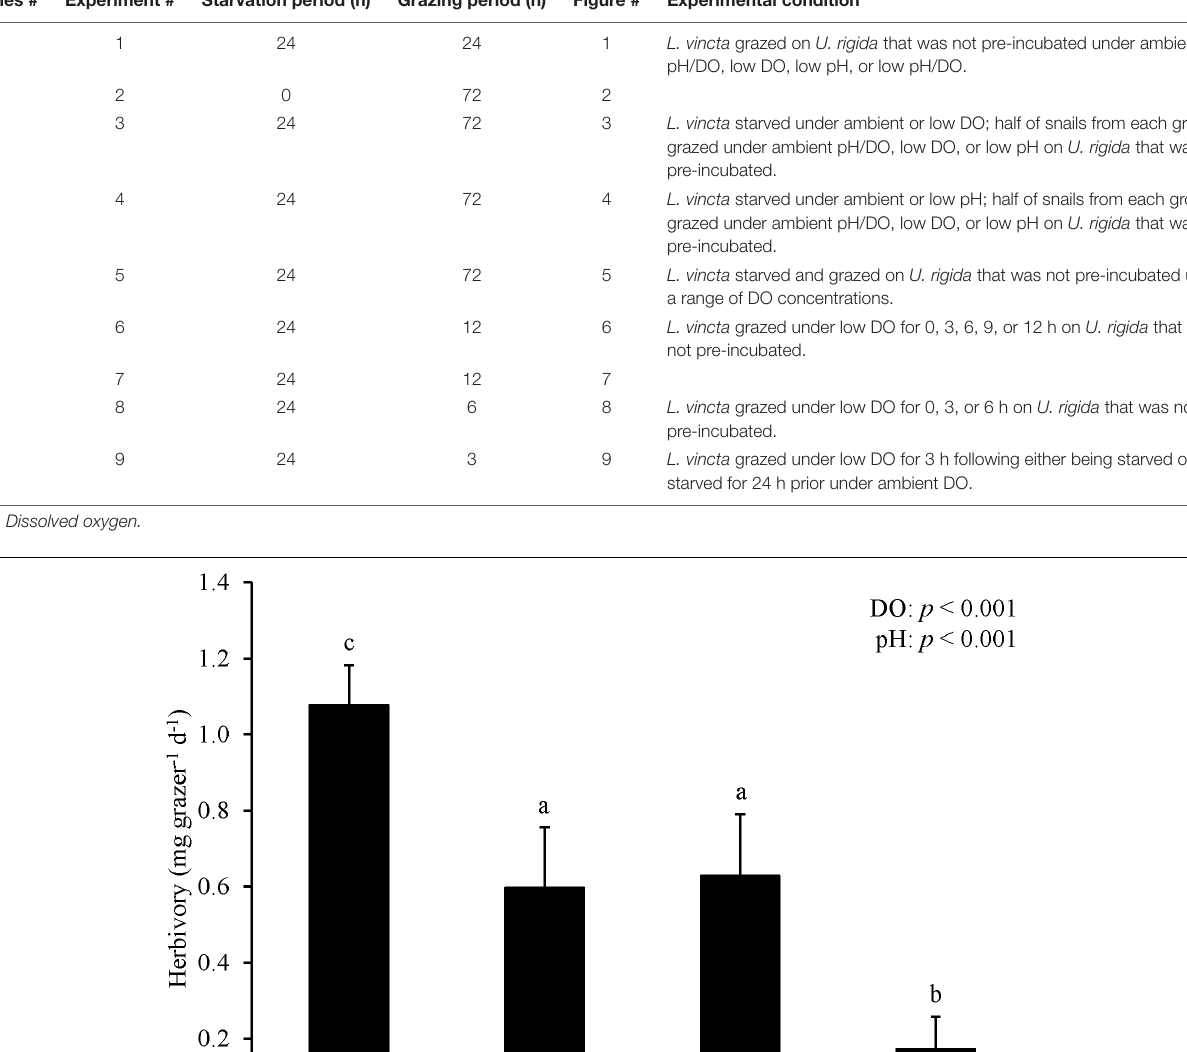
TABLE 2 | Experiments with their respective starvation and grazing periods and conditions. Series # Experiment # Starvation period (h) Grazing period (h) Figure # Experimental condition